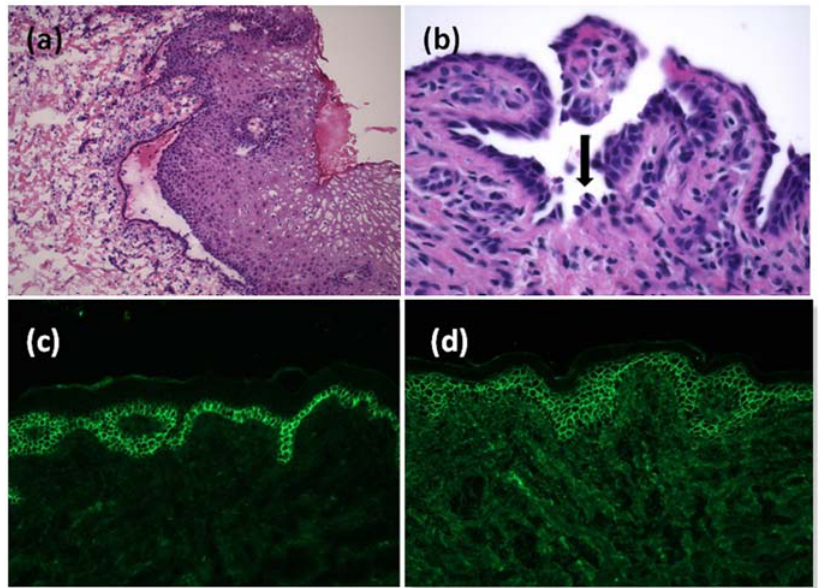
Figure 2. Histopathological examination of the mucosa at small magnification showed a detachment of the epithelium from the chorion ( a ). Acantholysis in histological examination of the skin, with some keratinocytes looking similar to tombstones (black arrow) ( b ). Positivity for C3 ( c ) and IgG ( d ) deposits showing a fishnet pattern at direct immunofluorescence on the skin biopsy.